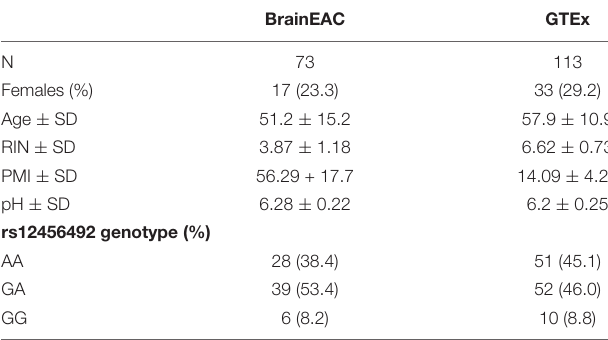
TABLE 1 | Demographic and genotype statistics for the BrainEAC and genotype-tissue expression (GTEx) datasets.